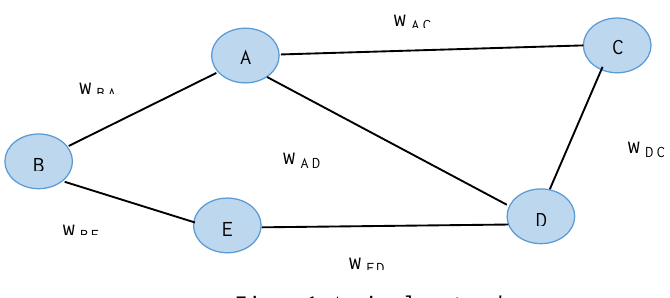
Figure 1. A simple